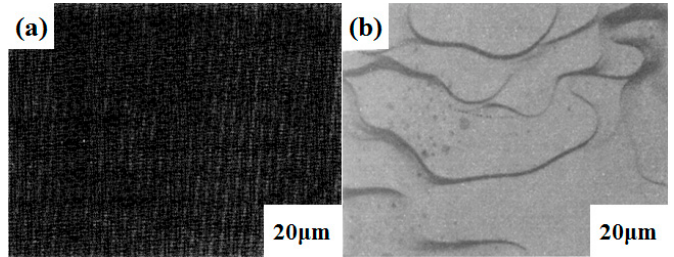
Figure 2. Typical surface morphologies of GaSb epilayers ( a ) grown on a (100) substrate at 550 °C from a Ga-rich melt and ( b ) on a 7° off-axis (111) substrate at 660 °C from an Sb-rich melt. Reproduced with permission from [15], copyright Springer (1995).